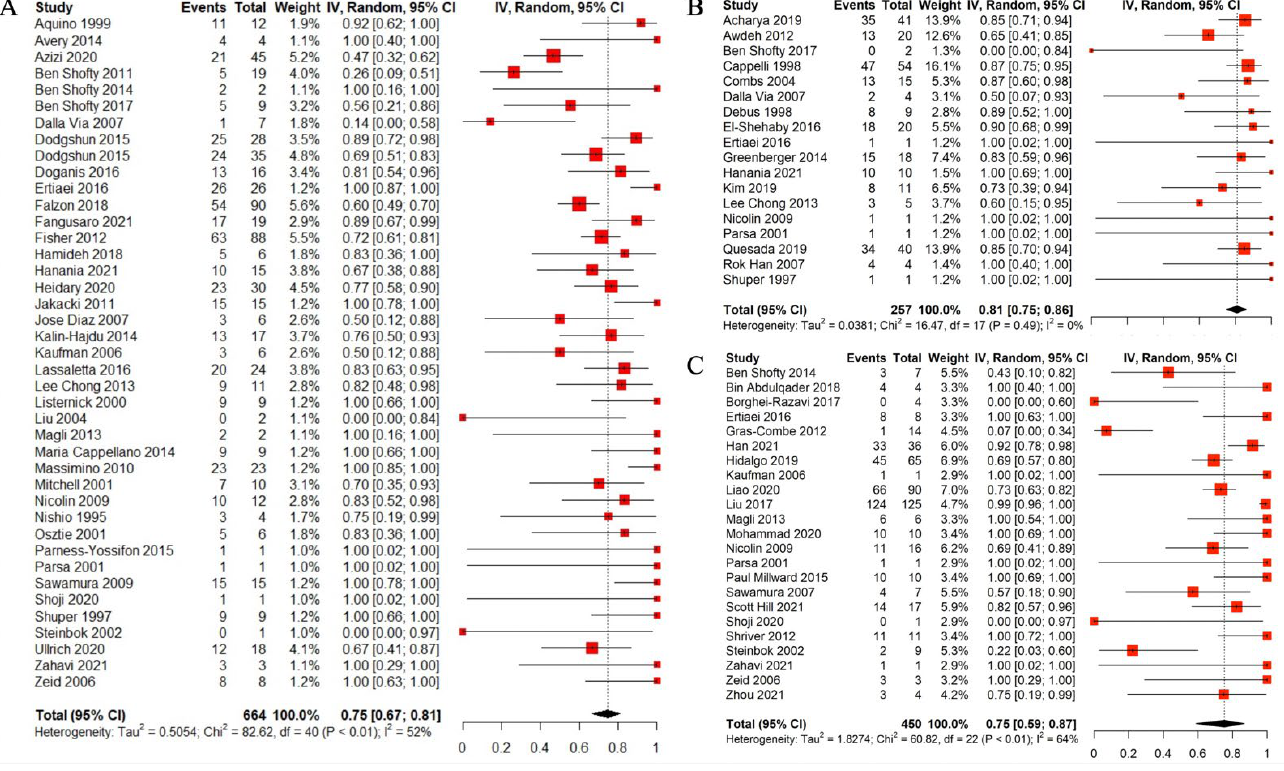
Figure 3. Forest plots for clinical outcome following each modality. ( A ) Chemotherapy, ( B ) radiotherapy, and ( C ) surgery [14–118].